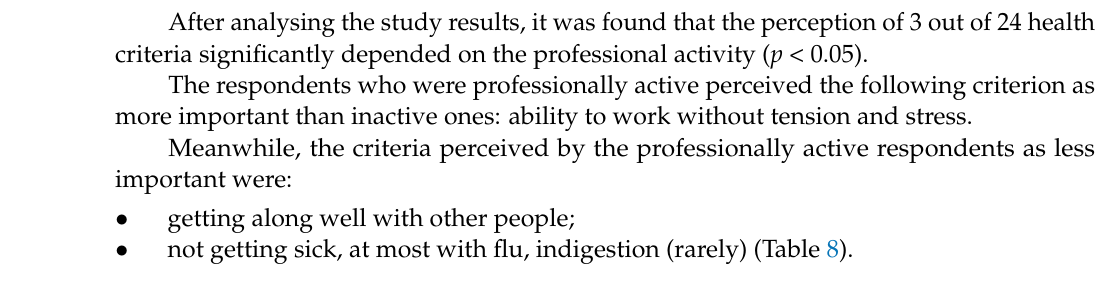
Table 8. Correlations of health statements with the professional activity of the respondents. Criterion Professionally